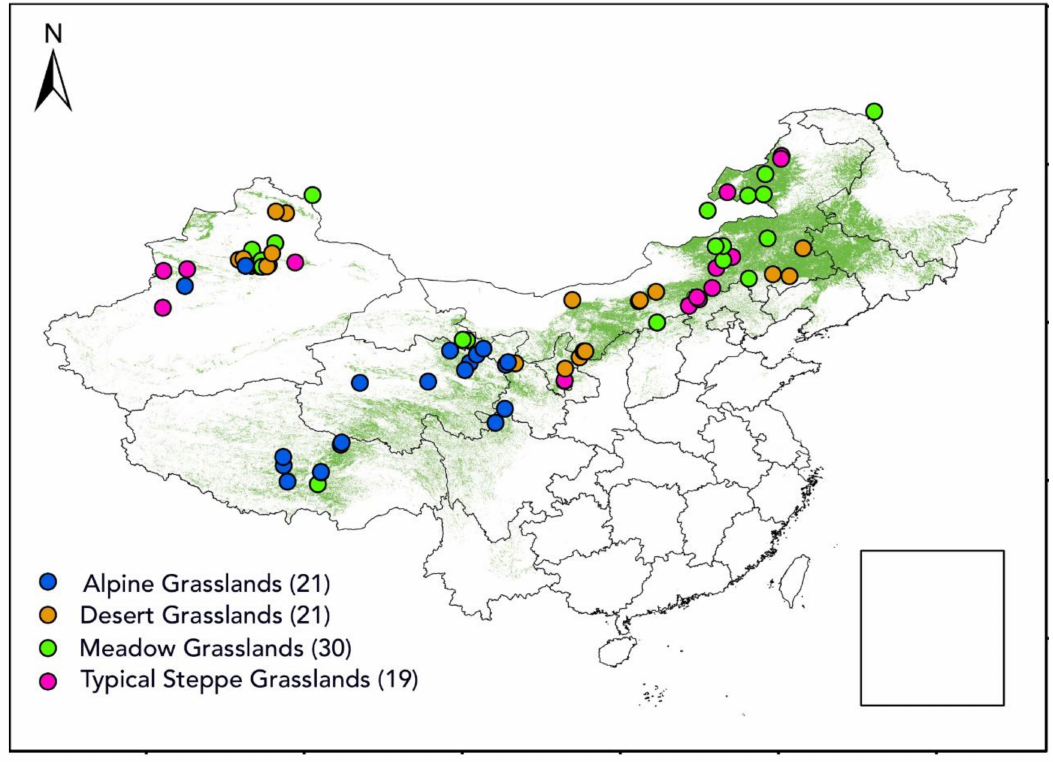
Figure 1. Study sites included in this meta-analysis (colored dots). Numbers represent the number of articles for the grassland